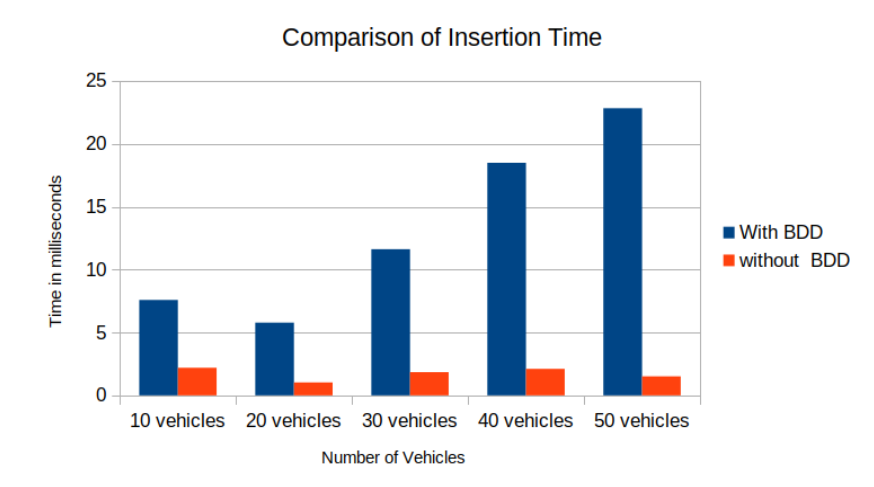
Figure 14. Layer 4 data insertion time with BDD vs. without